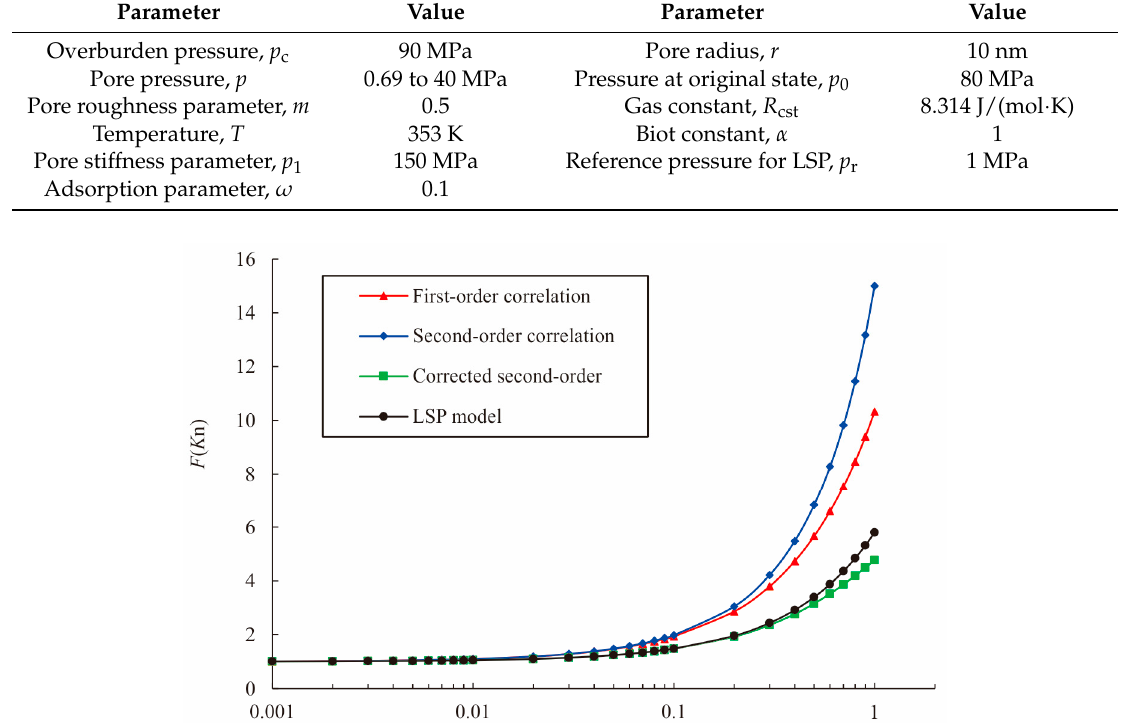
Figure 6. Bulk phase gas-permeability model validation compared with published data [70,71].